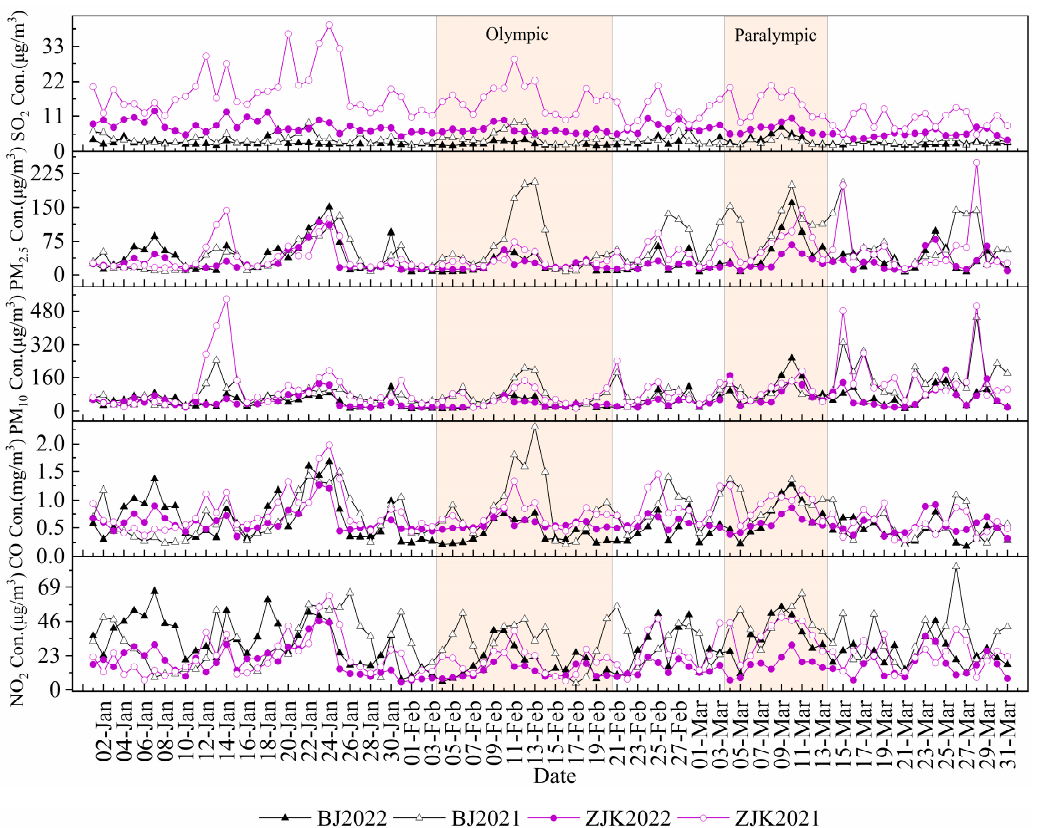
Figure 3. Daily variations in pollutant concentrations in Beijing and Zhangjiakou during the study period.